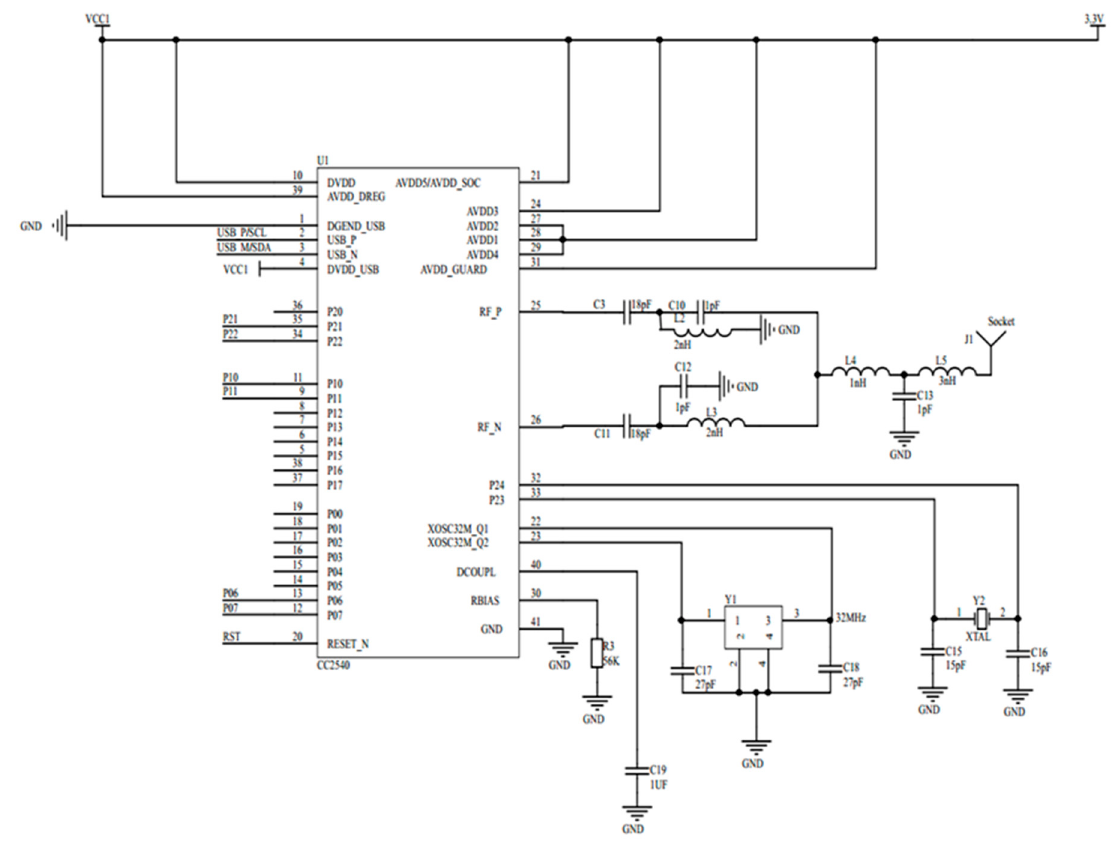
Figure 3. Microcontroller unit (MCU) and wireless module circuit.